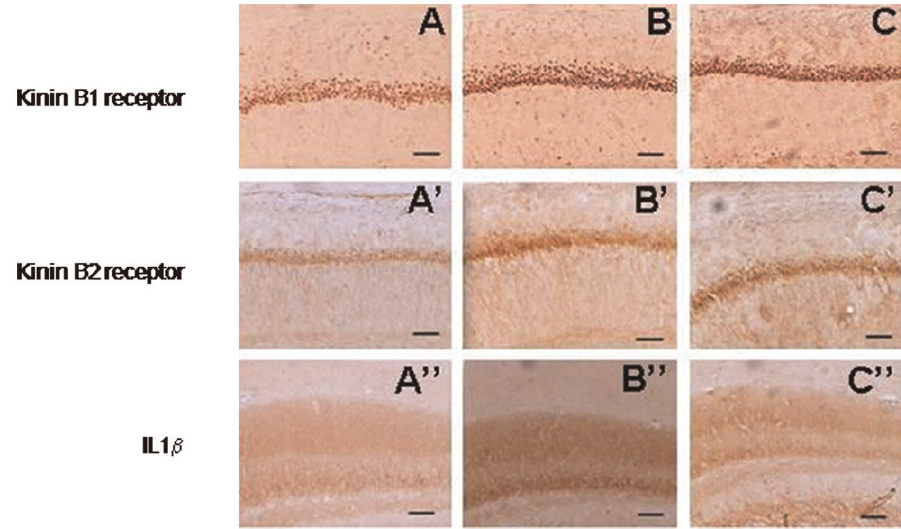
Figure 2 - Photomicrographs of the CA1 region of hippocampi processed for immunohistochemistry showing expression of the kinin B1 receptor (A, B and C), the kinin B2 receptor (A’, B’ and C’) and IL1 b (A’’, B’’ and C’’). Groups: A – saline-treated group; B – pilocarpine- treated group; and C – indomethacin-treated group. Scale bars: 0.02 mm.